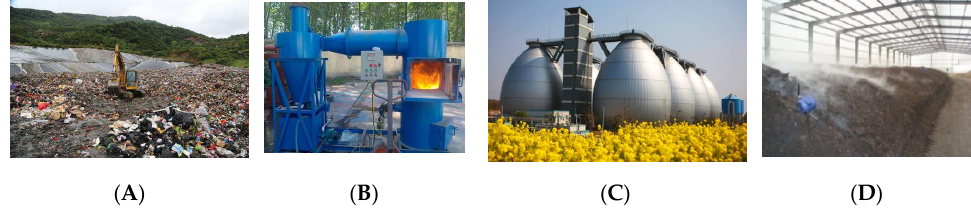
Figure 2. Conventional technologies for organic solid waste treatment. ( A ) Landfill; ( B ) incineration; ( C ) anaerobic digestion; ( D ) thermophilic composting [29] .